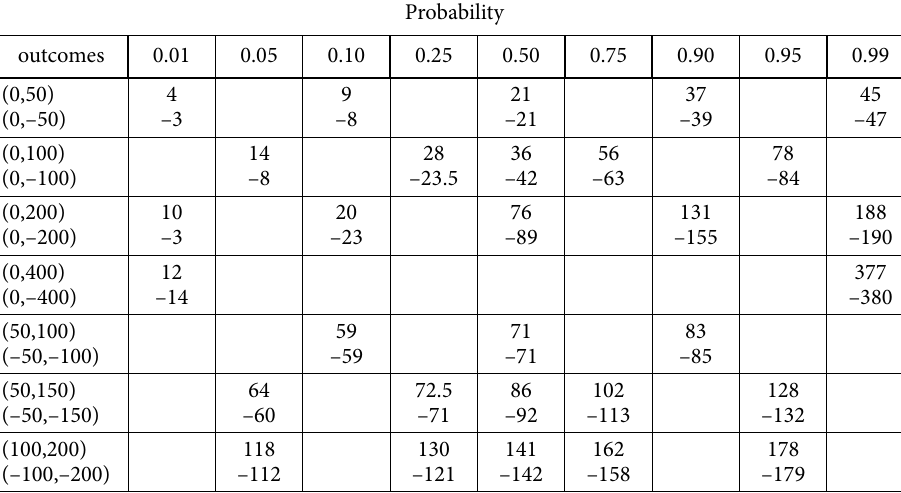
Table 2. Median cash equivalents for all nonmixed prospects (Tversky & Kahneman, 1992) Probability